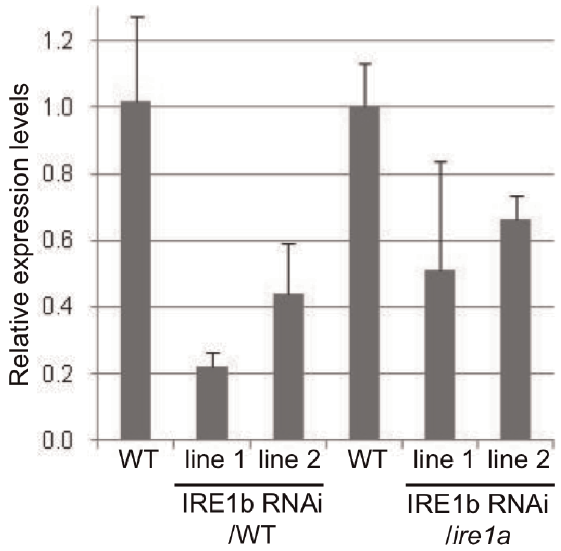
Figure 3. bZIP60 splicing in RNAi lines after heat stress treatment. Semi-quantitative RT-PCR showing bZIP60 splice variants in WT, ire1a mutant and IRE1b RNAi lines in WT and ire1a mutant backgrounds. Two independent lines are shown for each transformed construct. The full length and spliced variant are respectively indicated by black and grey arrowheads.